Question: How would you classify this visualization?
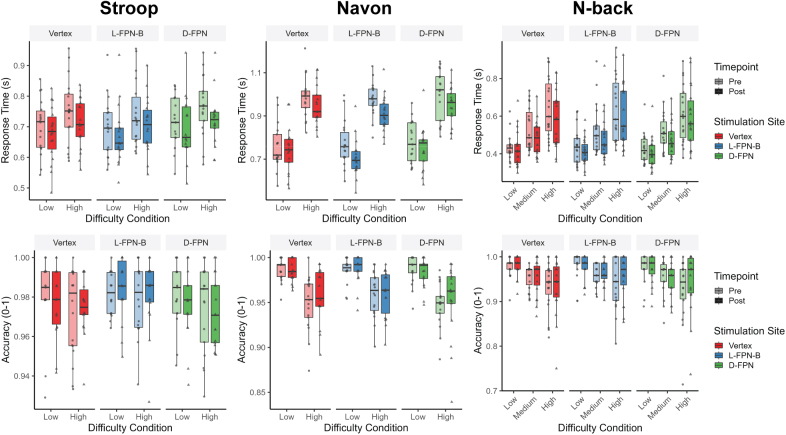
Answer: box